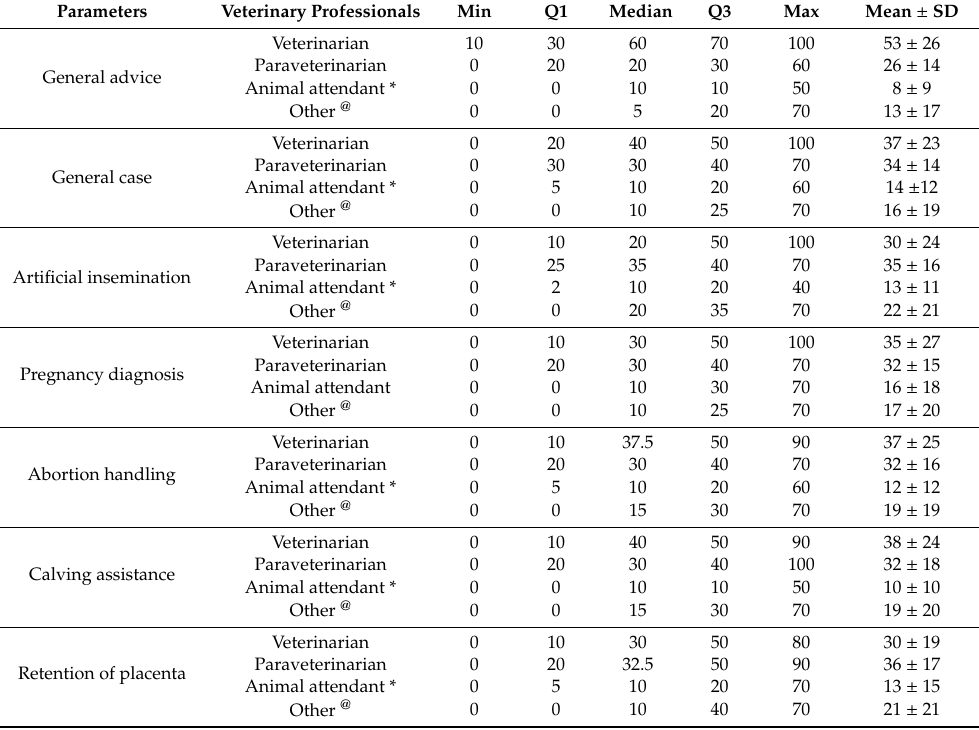
Table 3. The mean, median, minimum and maximum interquartile proportions of likely involvement of various veterinary service providers for advice and interventions for animal health services based on the responses to the questionnaire survey obtained from veterinary practitioners employed with the Department of Animal Husbandry, Government of Punjab during the study